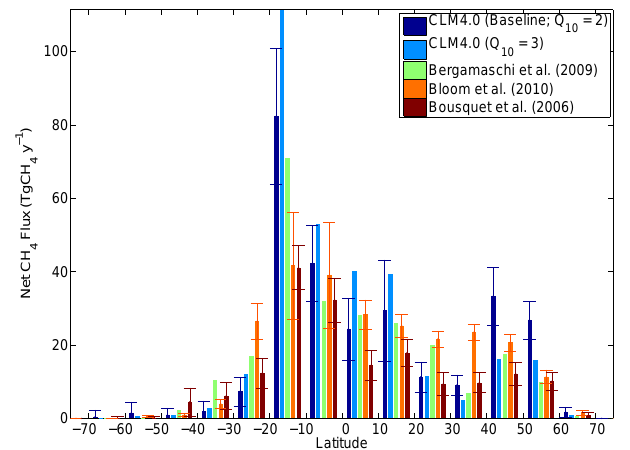
Fig. 5. Comparison between average-annual CH 4 estimates from CLM4Me with baseline parameters, CLM4Me with baseline pa- rameters except Q 10 = 3, and three atmospheric inversions (Bloom et al., 2010; Bergamaschi et al., 2009; Bousquet et al., 2006) for 10 ◦ latitude bands.